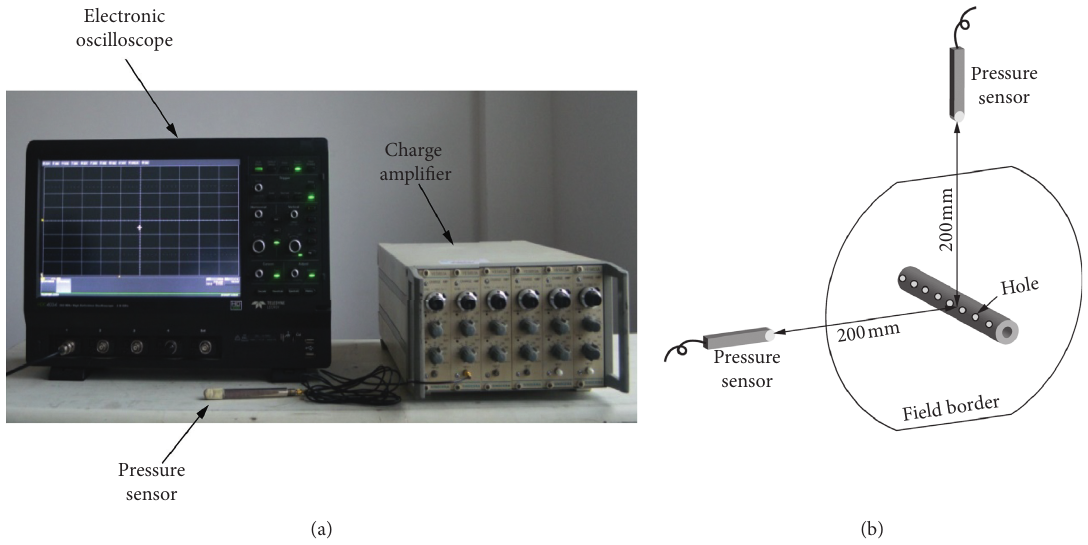
Figure 7: (a) Photo of overpressure measuring device. (b) Schematic of the overpressure test